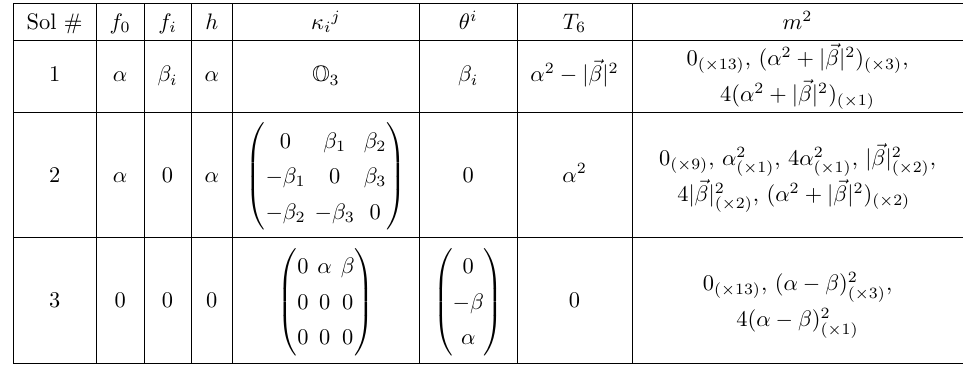
Table 4 . Critical points of the scalar potential induced by the compacti(cid:12)cation of mIIA with O6/D6. In this case all of the above solutions are Mkw. The solutions can be embedded into N = (2 ; 2) theory i(cid:11) T 6 vanishes. Mass eigenvalues are computed in g = 2 units. We use the notation ~(cid:12) (cid:17) ( (cid:12) 1 ; (cid:12) 2 ; (cid:12) 3 ).